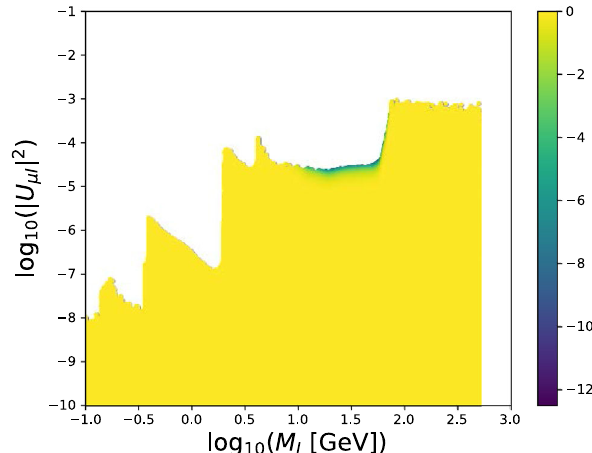
Fig. 31 Partial likelihood from direct searches with CMS, μ